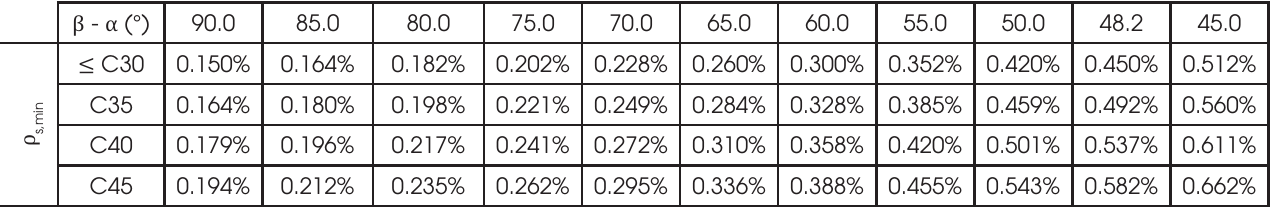
Minimum reinforcement ratio for different skew